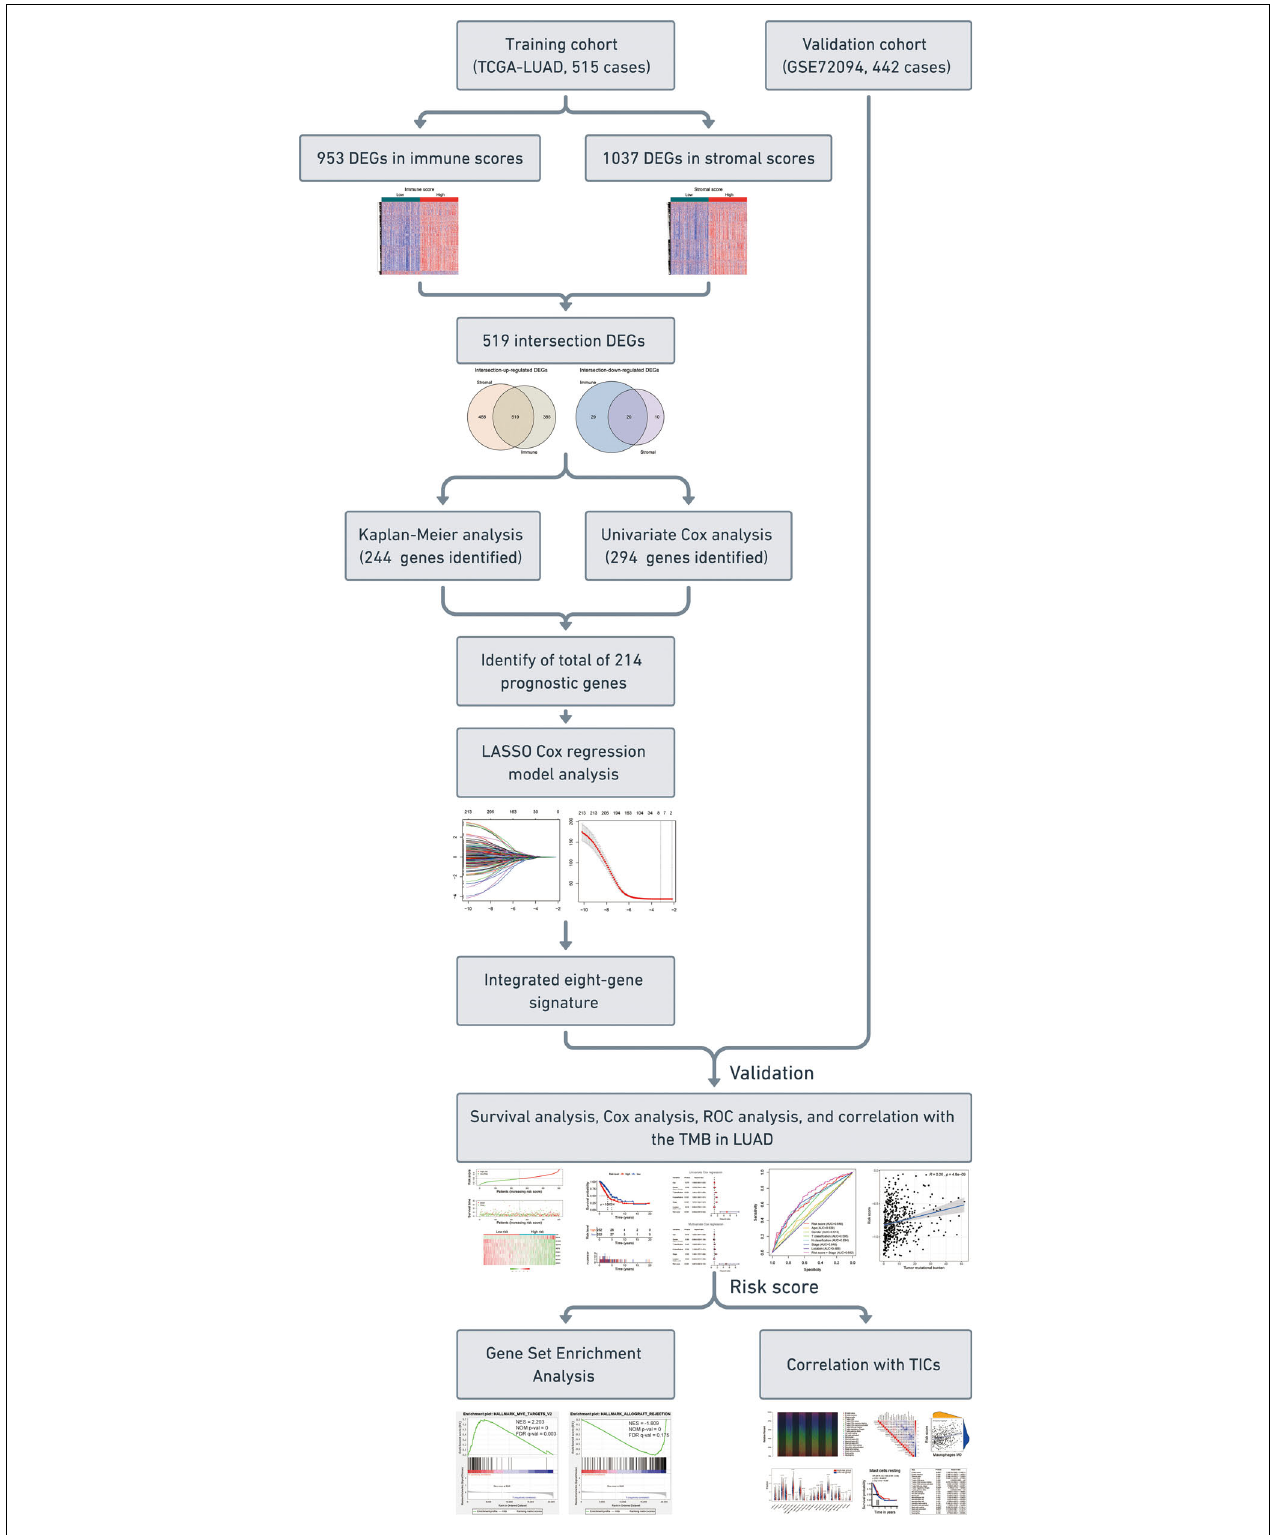
FIGURE 1 | Flow chart of the study. The study was carried out in TCGA-LUAD and GSE72094 cohorts. The training cohort was used to identify prognostic genes. The prognosis analysis was validated in the validation cohort. DEGs, differentially expressed genes; LASSO, the least absolute shrinkage and selection operator Cox regression model; ROC, receiver operating characteristic; TMB, tumor mutational burden; LUAD, lung adenocarcinoma; TICs, tumor-infiltrating immune cells.